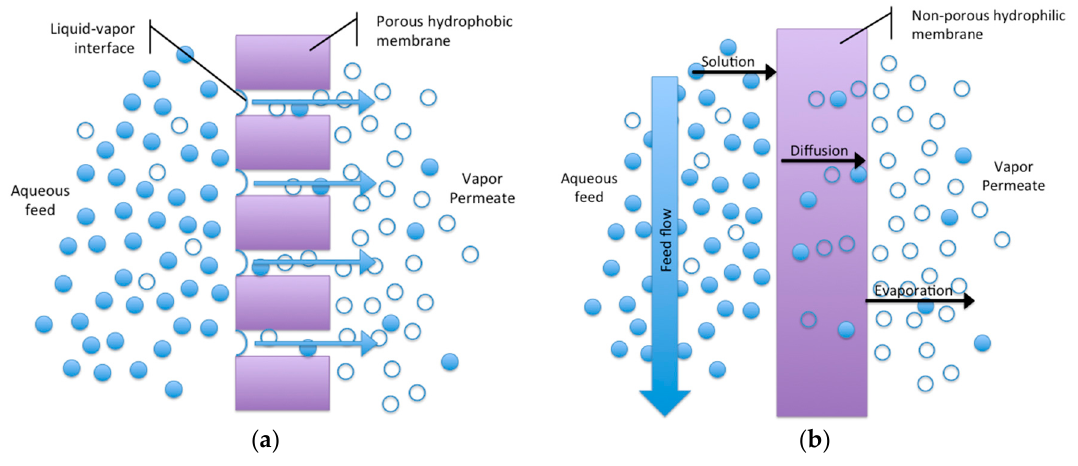
Figure 1. Comparison between ( a ) VMD and ( b ) PVD.